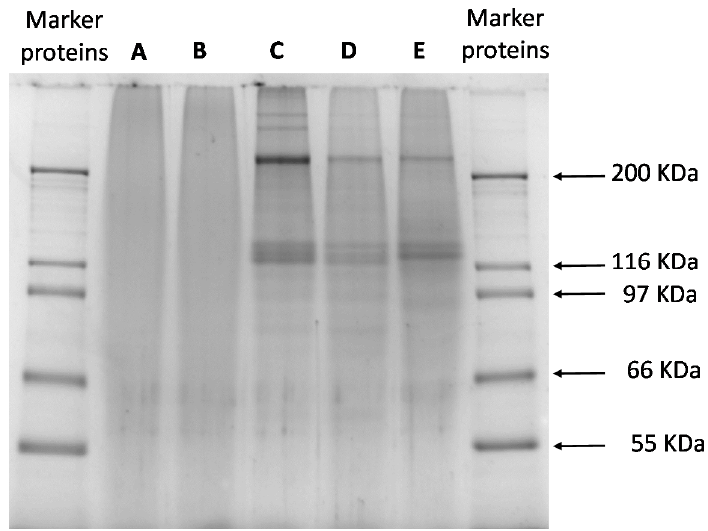
Figure 1. SDS-PAGE for commercial samples A and B from Sigma and Norland, respectively, and C, D, and E from different extraction protocols.